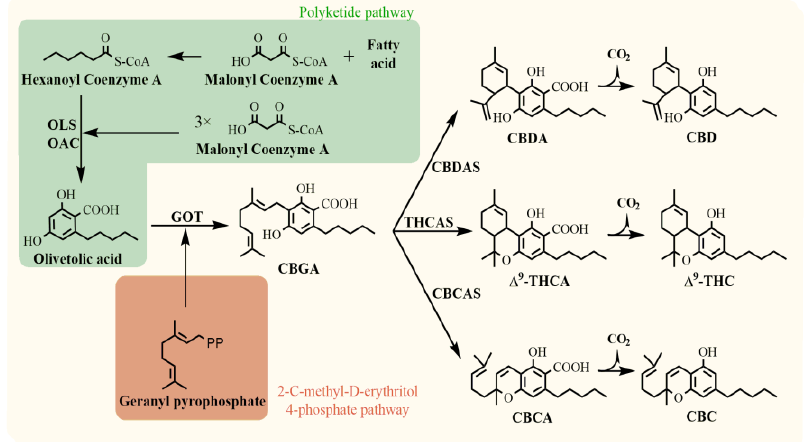
Figure 1. Biosynthesis of major phytocannabinoids. OLS, olivetol synthase; OAC, olivetolic acid cyclase; GOT, geranylpyrophosphate:olivetolate geranyltransferase; CBDAS, cannabidiolic acid synthase; THCAS, tetrahydrocannabinolic acid synthase; CBDAS, cannabichromenic acid synthase; CBGA, cannabigerolic acid; CBDA, cannabidiolic acid; ∆ 9 -THCA, ∆ 9 -tetrahydrocannabinolic acid; CBCA, cannabichromenic acid; CBD, cannabidiol; ∆ 9 -THC, ∆ 9 -tetrahydrocannabinol; CBC, cannabichromene [11,12].